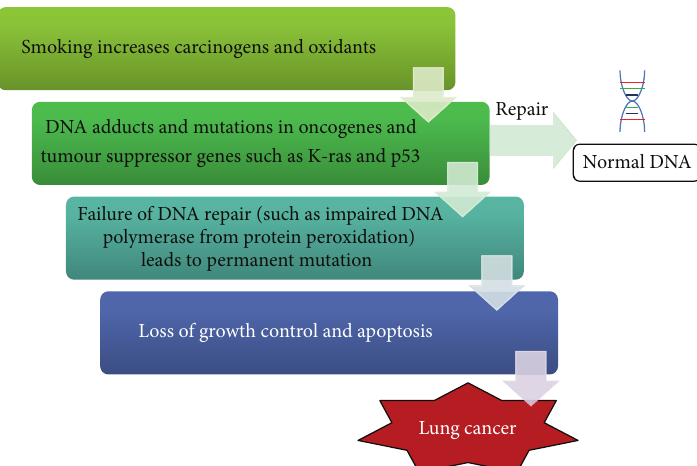
Figure 1: Stepwise progression towards lung cancer. Oxidants in cigarette smoking induce inflammation which subjects DNA to mutations. The failure to repair damaged DNA in critical coding regions causes cell proliferation and lung cancer.